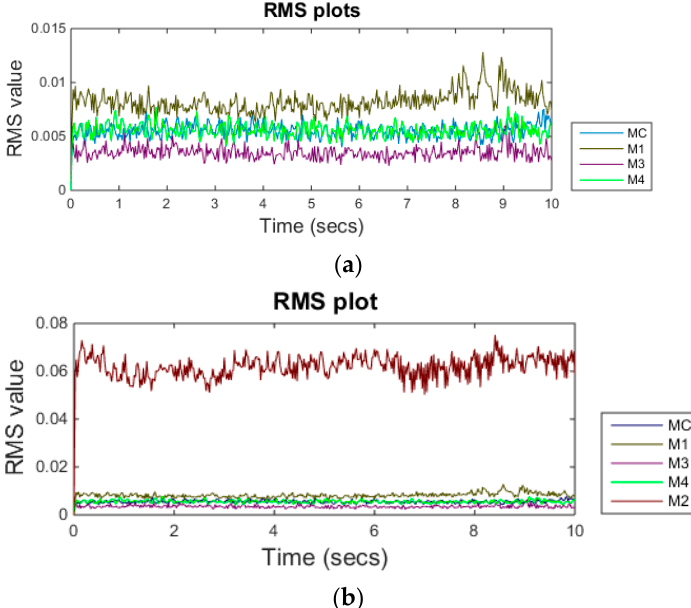
Figure 8 . ( a ) RMS plot of machines excluding M2 (above); ( b ) RMS plot of all machines (below).